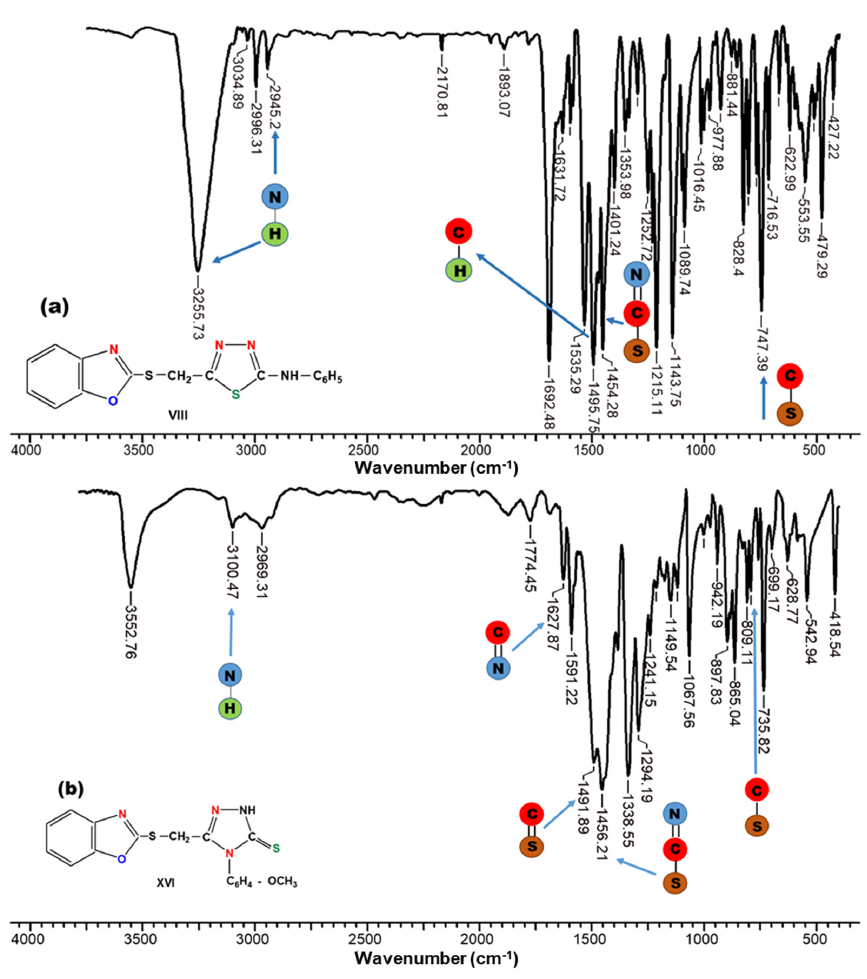
Molecules 2021 , 26 , x FOR PEER REVIEW 8 of 25